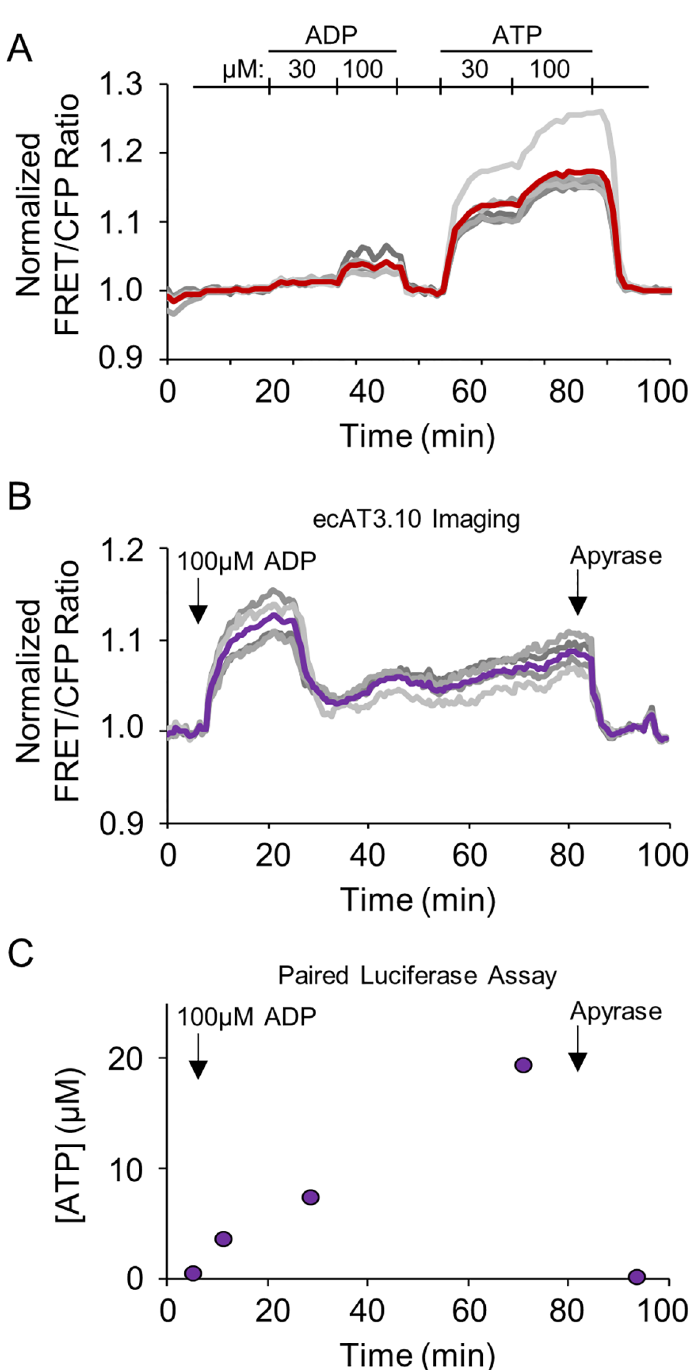
Fig 6. ecATeam3.10 detects ADP-stimulated releaseof endogenous ATP from live Neuro2A cells. (A) ecAT3.10-expressing Neuro2Acells were imaged under continuous perfusion conditionsto demonstrate that ecAT3.10 has greater sensitivity to ATP comparedto ADP. (B) Under static bath conditions, paired measurements by ecAT3.10 real-time imagingand endpointluciferase assays demonstrate that ADP stimulatesATP release. In (A) and (B) grey traces are individual cells, and the bold trace is the cell mean. Arrows in (B) and (C) indicatethe additionof ADP and apyrase, sequentially. In (C), time points represent samples from the bath solutiontaken duringthe ecAT3.10 imagingexperiment shown in (B).